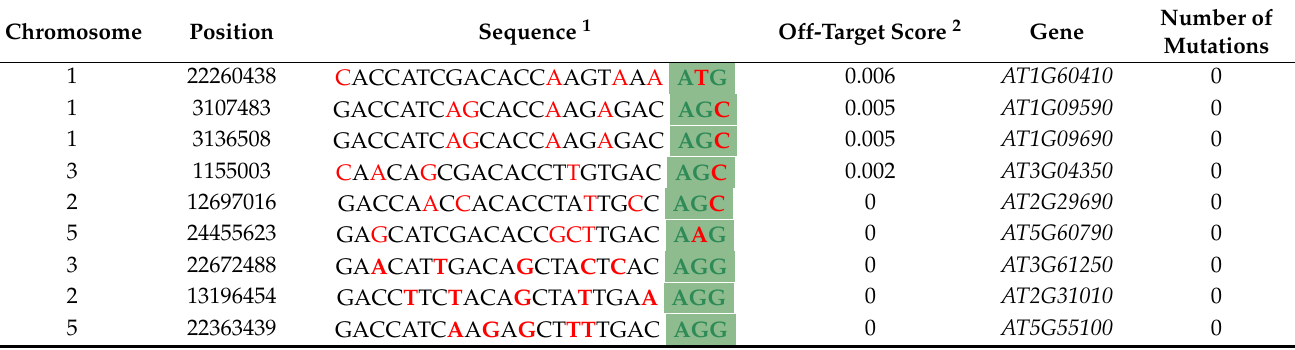
1 Three-base PAM sequence highlighted in green, mismatched bases indicated with red font color. 2 Off-target scores are cited from CRISPR-GE